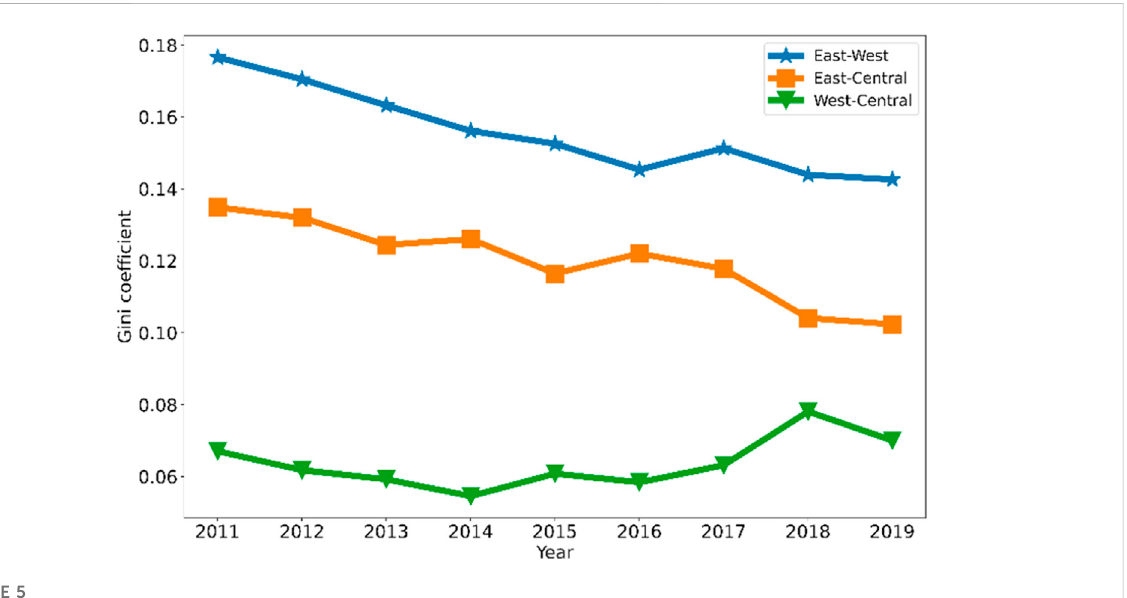
FIGURE 5 Gini coef fi cient values by